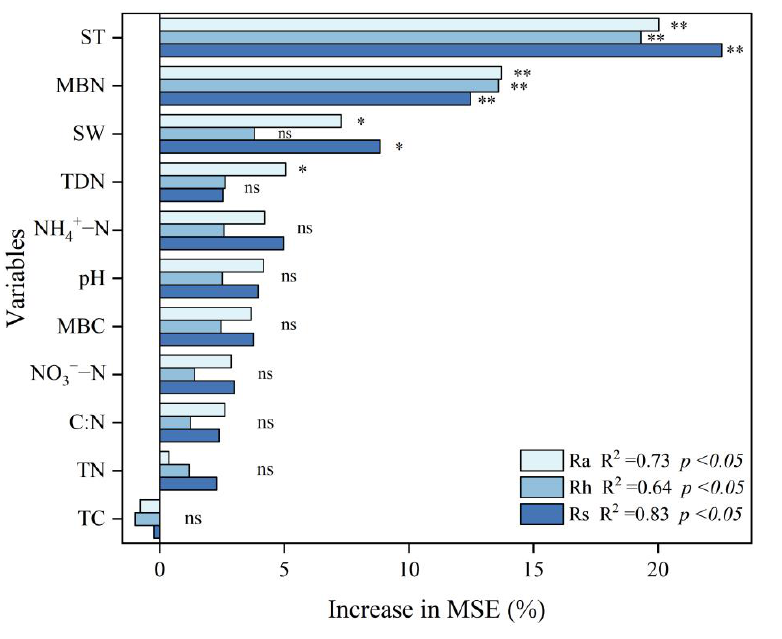
Figure 6. Bar chart showing the relative contributions of the factors influencing soil respiration and its components. The importance of predictor variables was evaluated using the percentage increase in the mean squared error (%) calculated using a total of 100 runs of the random forest model. ST, soil temperature; SW, soil moisture; NH 4+ -N, ammonium nitrogen; NO 3 − -N, nitrate nitrogen; TDN, total dissolved nitrogen; TN, total nitrogen; TC, total carbon; C:N, carbon:nitrogen; MBC, microbial biomass carbon; MBN, microbial biomass nitrogen. ** p < 0.01, * p < 0.05; ns indicates p > 0.05.